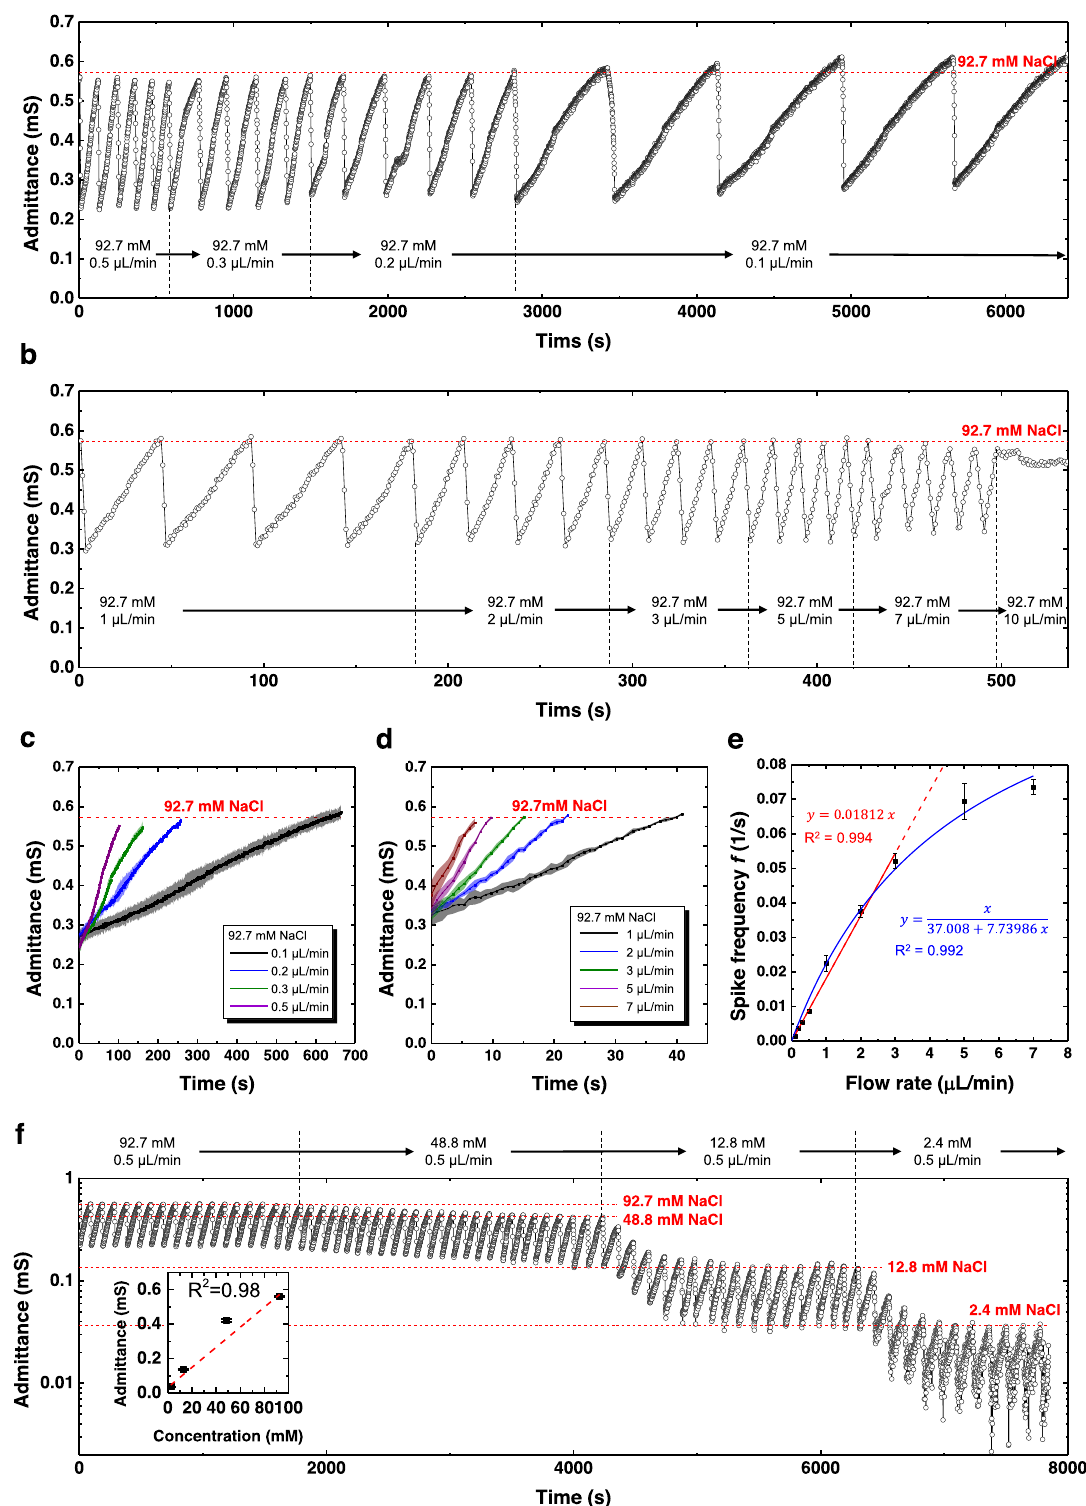
Fig. 4 | Encoding the fl ow rate and ionic conductivity into admittance spikes using the sweat VIA sensor. Continuous monitoring of the electrical admittance when the simulated sweat (92.7mM NaCl solution, which has a conductivity of 10,350 μ S/cm)experiencesachangeof fl owrate a from0.1to0.5 μ L/minand b from 1to10 μ L/min.Theaveragespikingsignalsoftheadmittancecurveateach fl owrate of c 0.1 – 0.5 μ L/min and d 1 – 10 μ L/min. e . Dependence of spike frequency on the fl owratecalculated from theadmittancecurvesin a and b .Thedatapointsfor fl ow